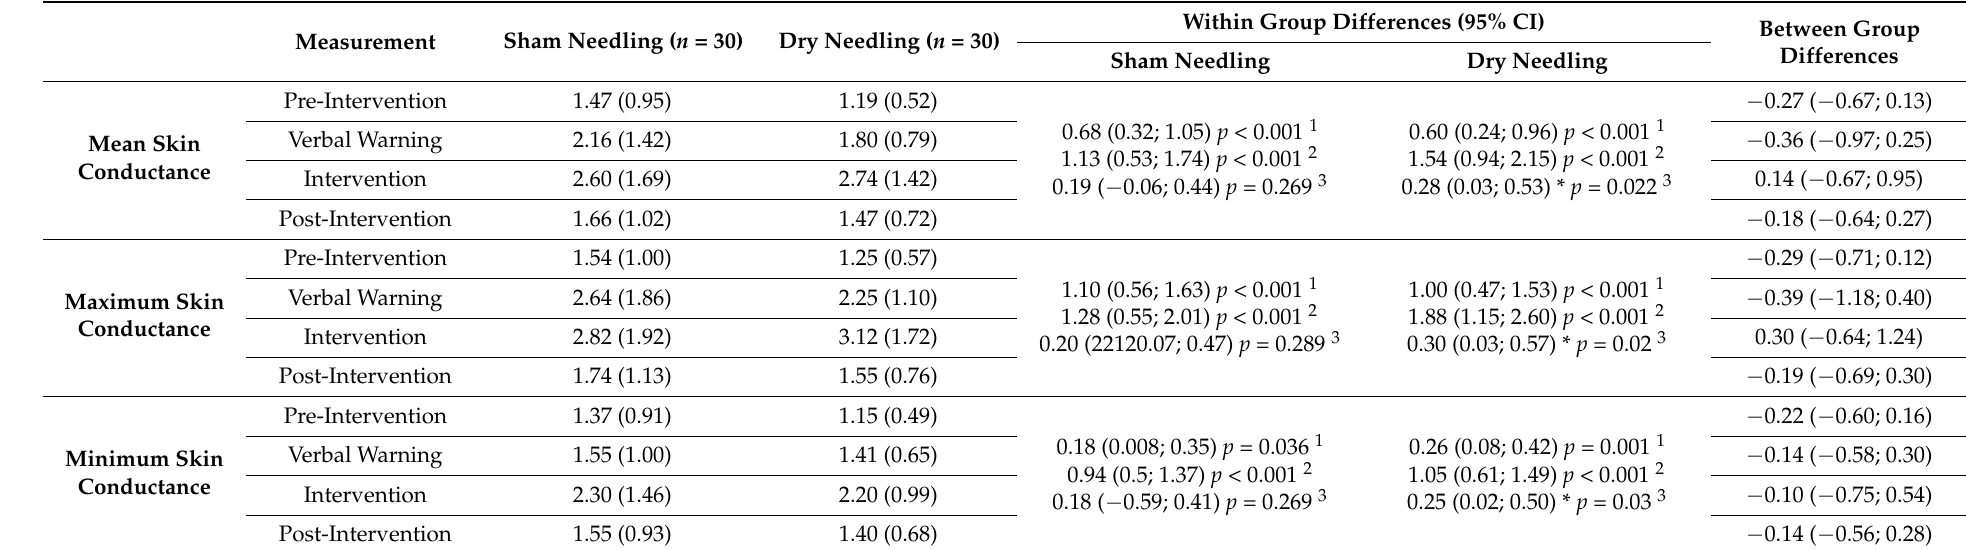
Table 2. Skin conductance measurements in both real and sham needling groups.